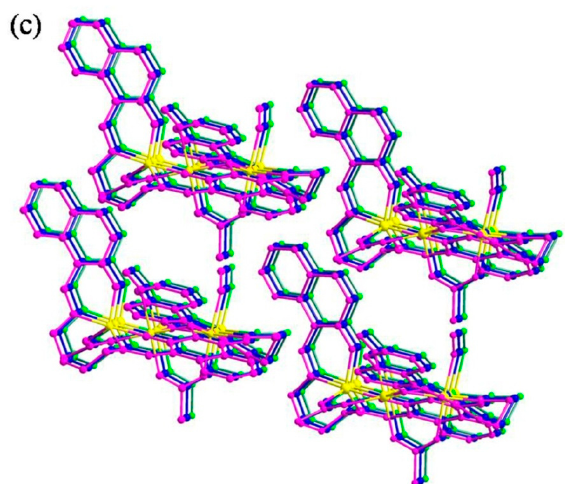
Figure 6. ( a ) View of the 1D chain structure of the Co(II) complex; ( b ) View of the 2D layer-like network of the Co(II) complex; ( c ) Packing diagram of the Co(II) complex.